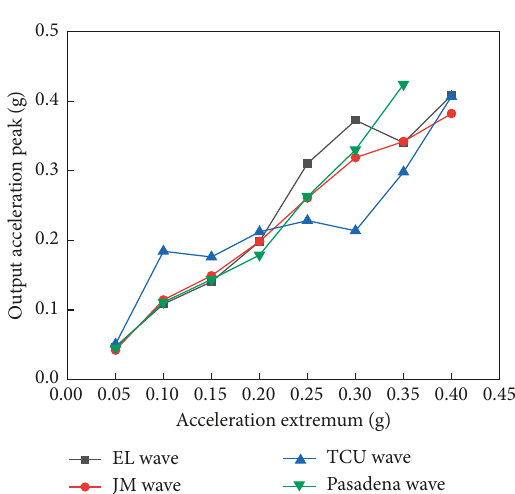
Figure 1: Test layout.